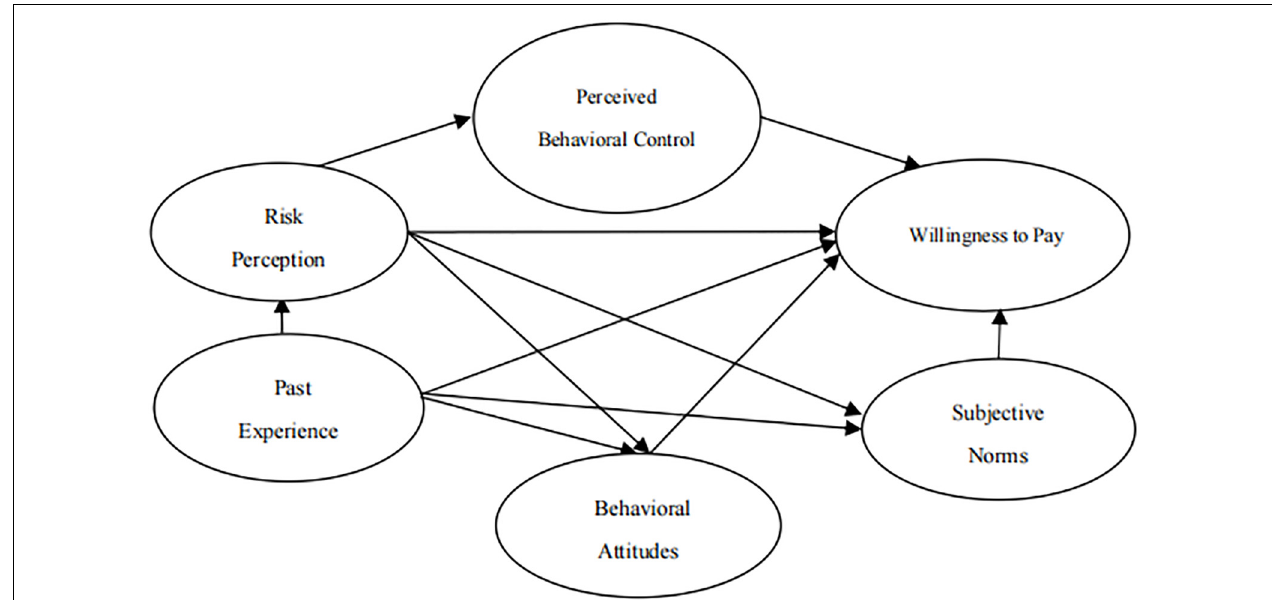
FIGURE 1 | Research hypothesis